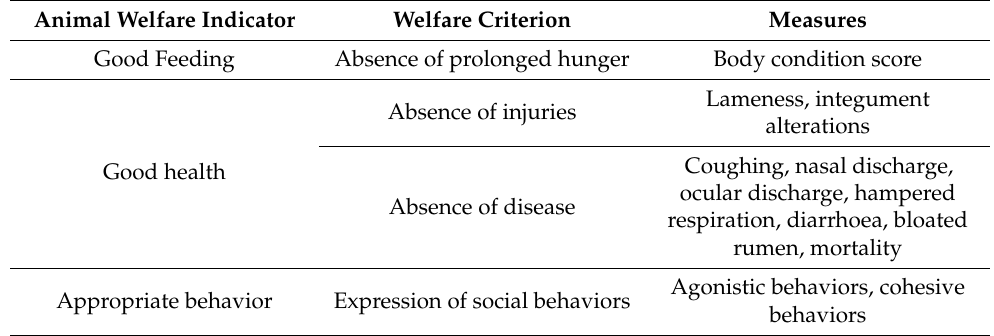
Table 2. Some measures based on the Welfare Quality ® assessment protocol. Adapted from ref. [23]. Animal Welfare Indicator Welfare Criterion Good Feeding Absence of prolonged hunger